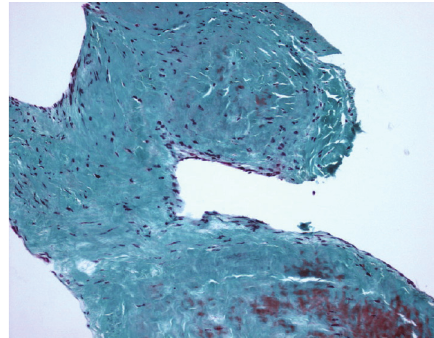
Figure 7: Histopathology: trichrome stain, magnification 100x.